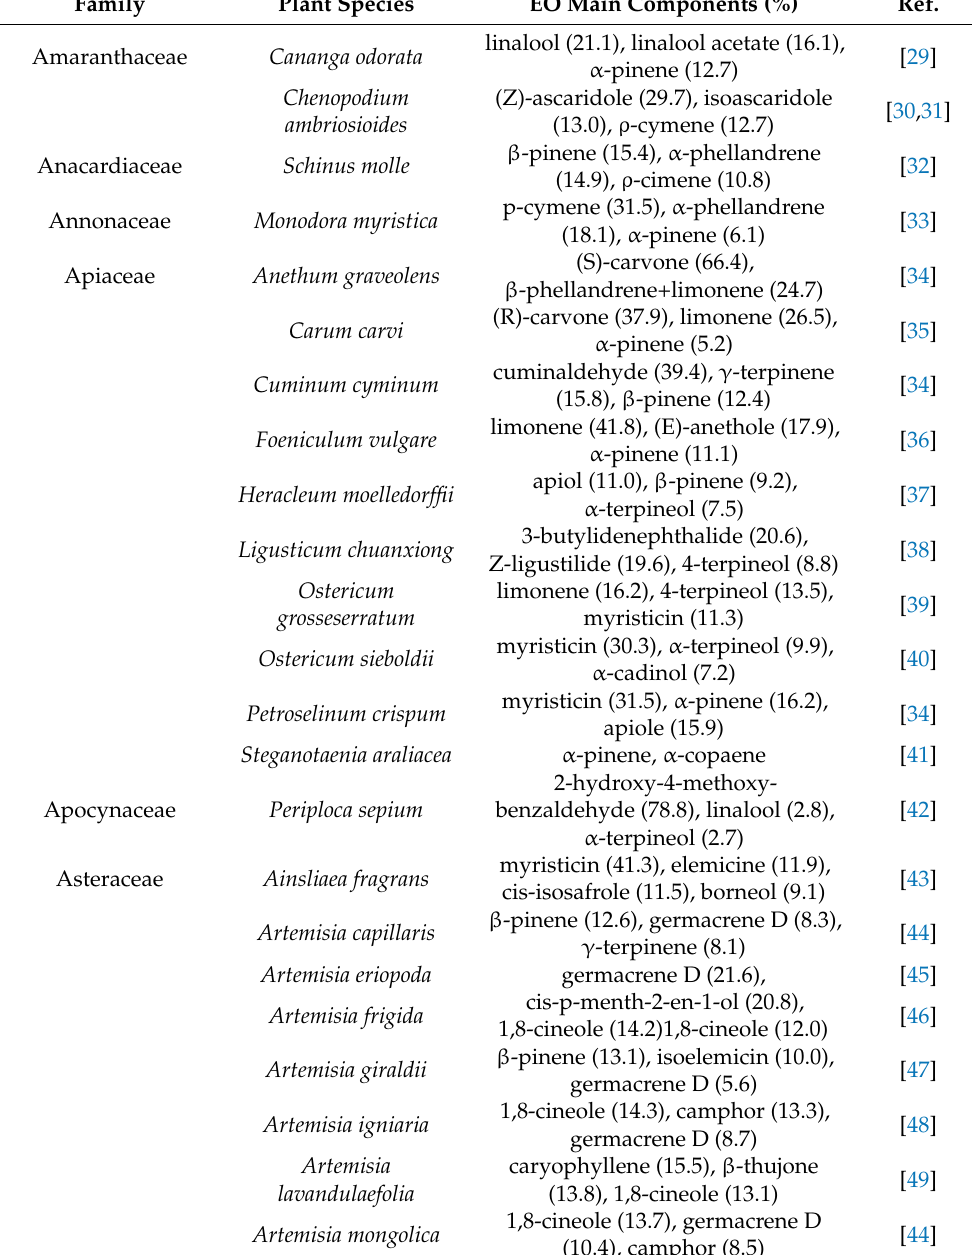
Table 1. Main components of the plant EOs evaluated for their direct and indirect contact toxicity against S.